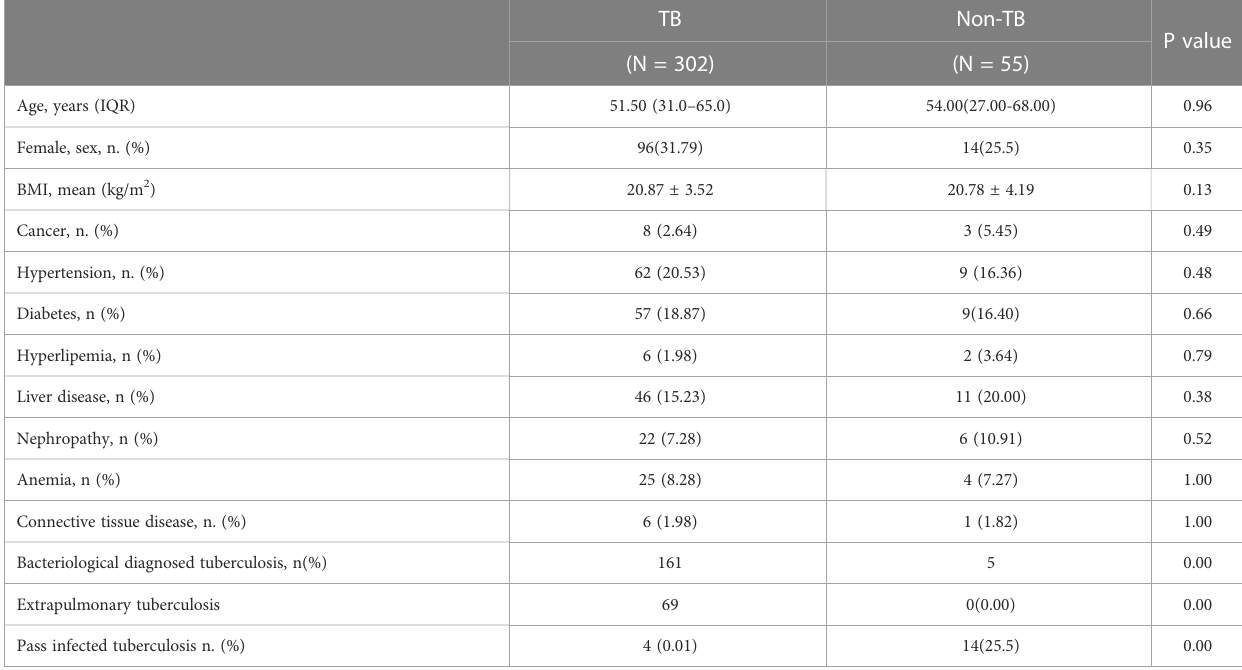
TABLE 1 Clinical characteristics of the participants in the tuberculosis and non-tuberculosis groups.